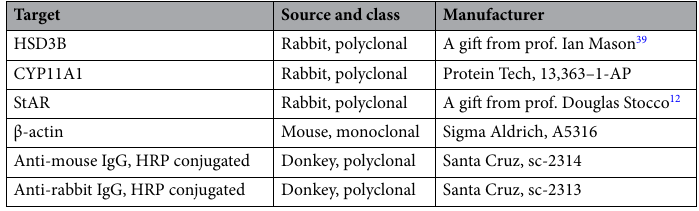
Table 2. Antibodies used for Western